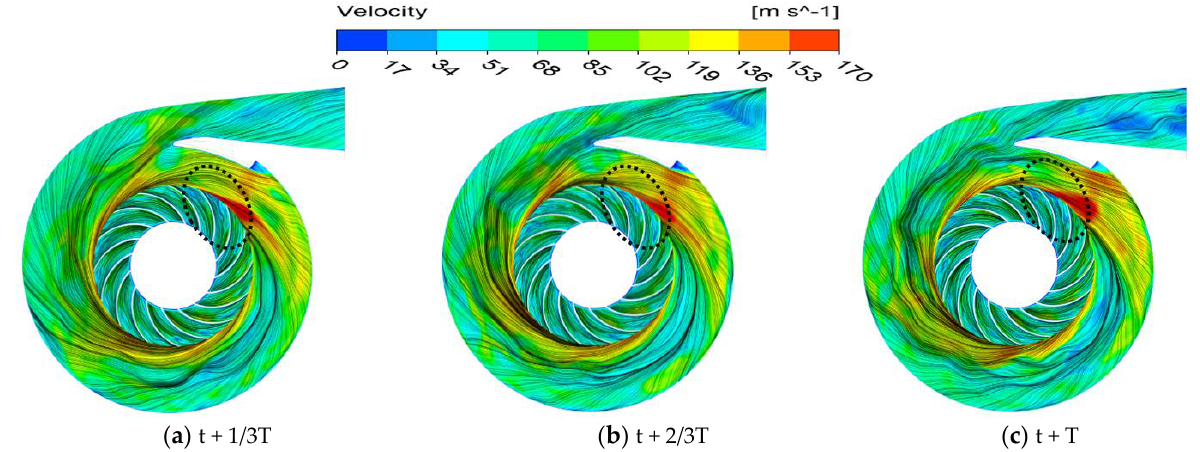
Figure 9. Development of the velocity andstreamlineat z = −12 mm cross -sectionand the near-stall